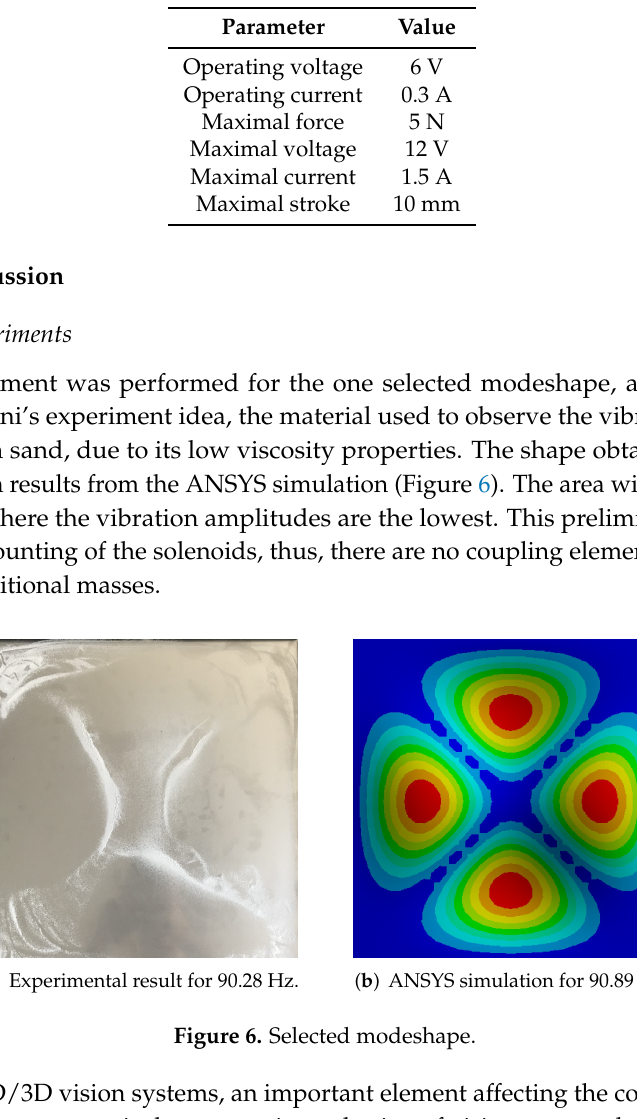
Table 1. The main parameters of solenoids.